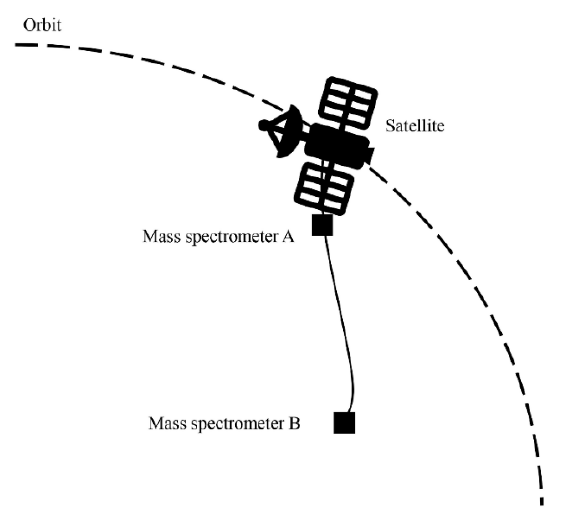
Figure 8. The schematic diagram of Satellite tethered Mass Spectrometer Detection.